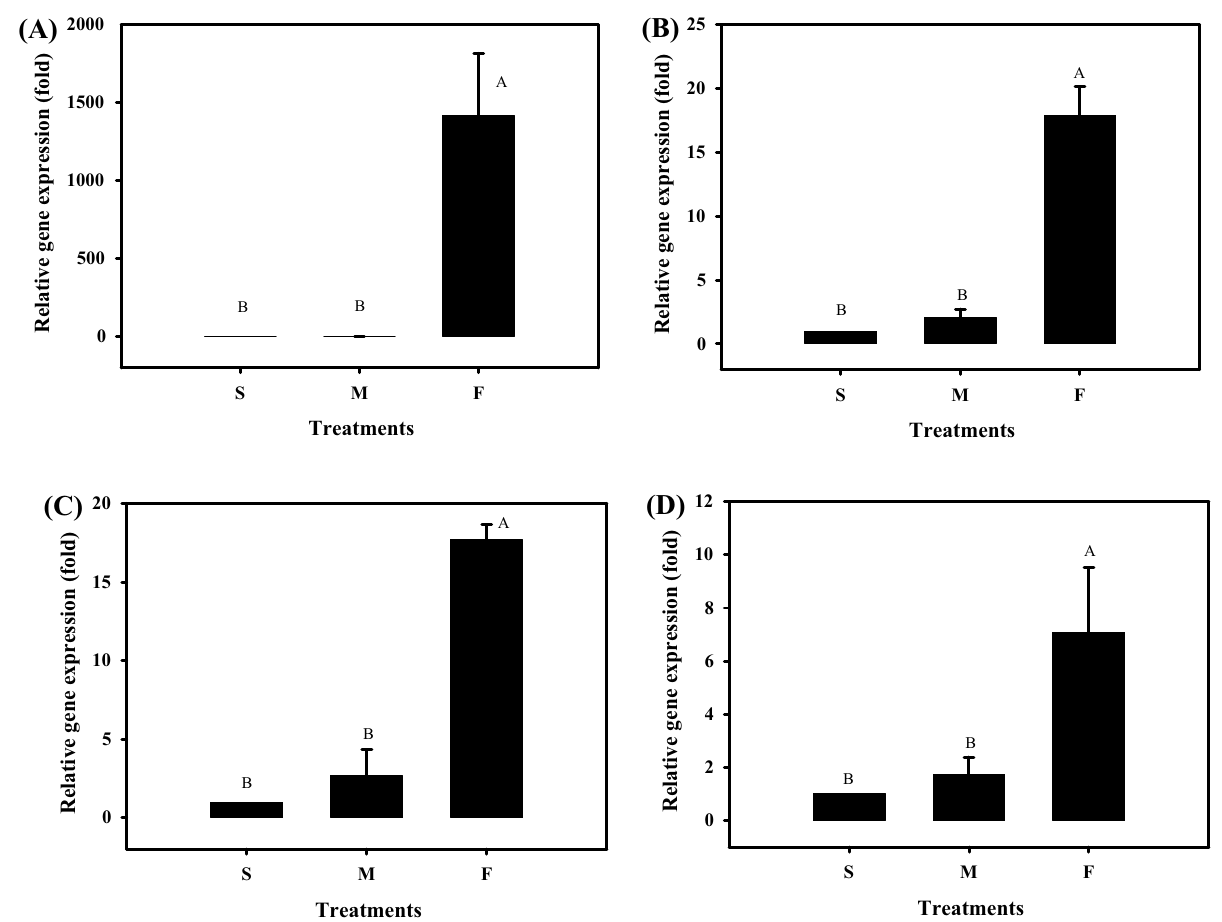
Figure 2. Quantitative reverse transcription-polymerase chain reaction (qRT-PCR) analysis of ( A ) major royal jelly protein 1 expression in the head, ( B ) vitellogenin expression in the abdomen, ( C ) hymenoptaecin expression in the abdomen, and ( D ) apidaecin expression in the abdomen of honey bees after feeding them with the Leuconostoc mesenteroides TBE-8 fermented broth. RNA samples obtained from the heads and abdomens of 7-day-old workers fed with 50% sucrose syrup (S), MRS medium containing 50% sucrose (M), or the TBE-8 fermented broth containing 50% sucrose (F) since they emerged were prepared for qRT-PCR. The relative gene expression was analyzed using the 2 −ΔΔ C T method. Data represent the mean of four repeats, with error bars indicating the standard deviation. The letters A and B indicate statistically significant difference ( P < 0.0001) accordingly to the least significant